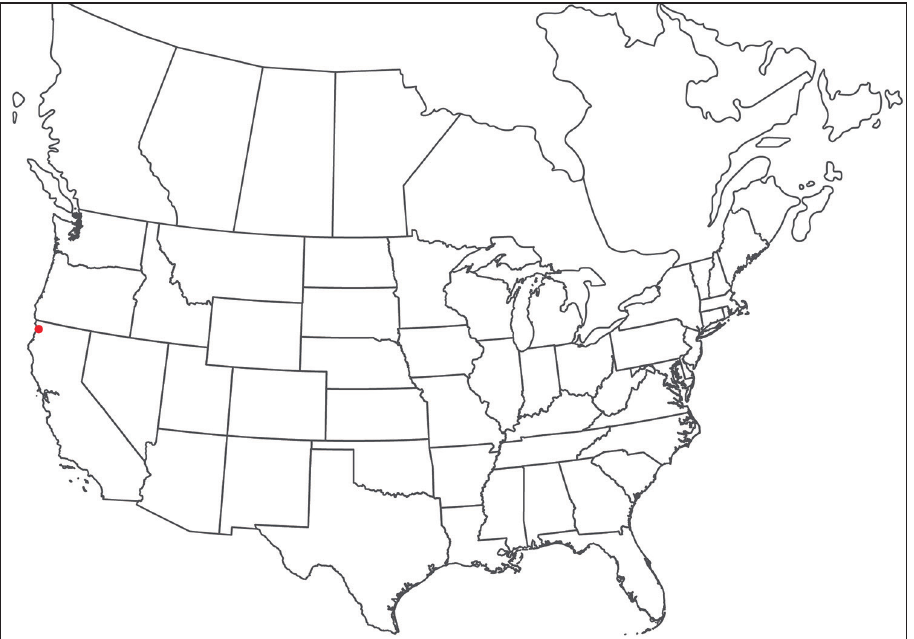
Figure 146. Torrenticola miniforma